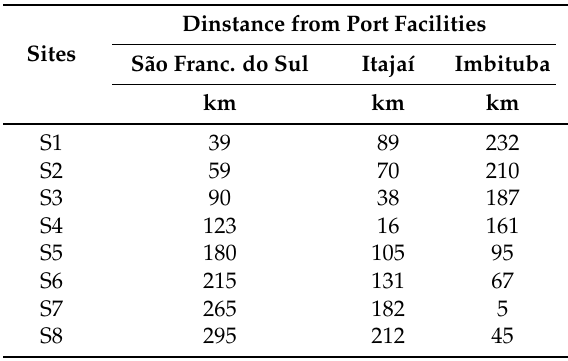
Table 6. Distance of each site from the three ports in Santa Catarina.